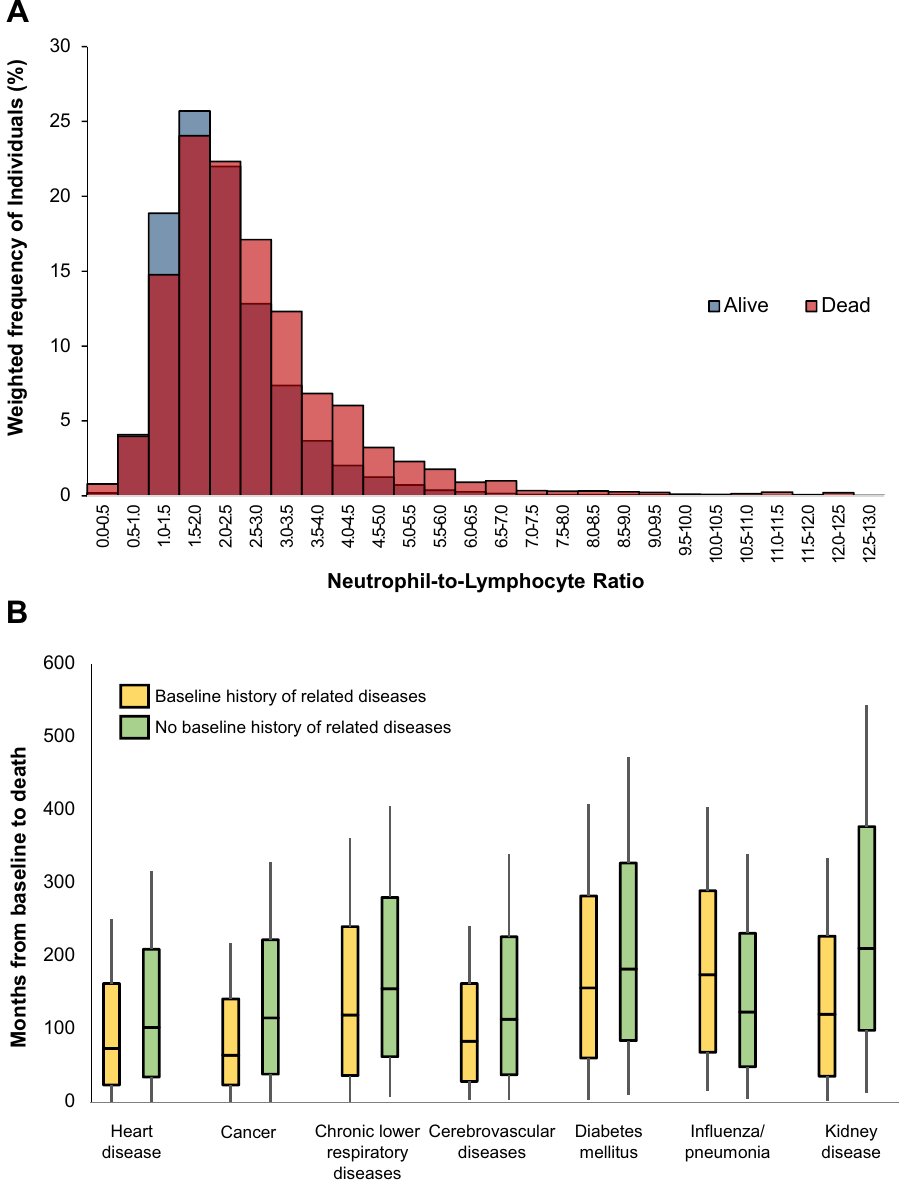
Figure 1. ( A ) Distribution of neutrophil-to-lymphocyte ratios among individuals according to vital status on follow up date. Results are weighted using NHANES survey sample weights. The x-axis is truncated at an NLR of 13, and not included in the graph are N = 11 surviving participants (weighted percentage 0.03%) and N = 11 deceased (0.20%) with greater values. ( B ) Follow-up time (months) in individuals who died from specified diseases, with or without those diseases at